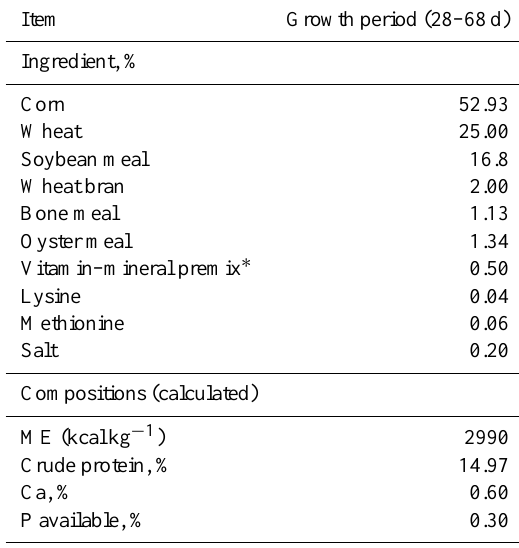
Table 1. Ingredients and nutrient specifications of experimental di- ets for